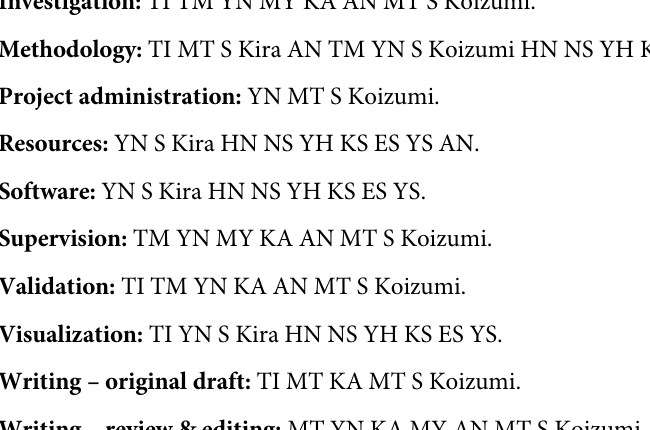
S3 Fig. Detection of Clock binding to the promoter region of mPer2. Each graph was described with the normalized value by the input DNA in each time point. Data are presented as a relative value of that of the control at each time point, and as means ± SE. (n = 3 for the Control group and anti-Clock Ab group at each time point). (cid:3) P < 0.05, Mann-Whitney’s U - test, n.s., not